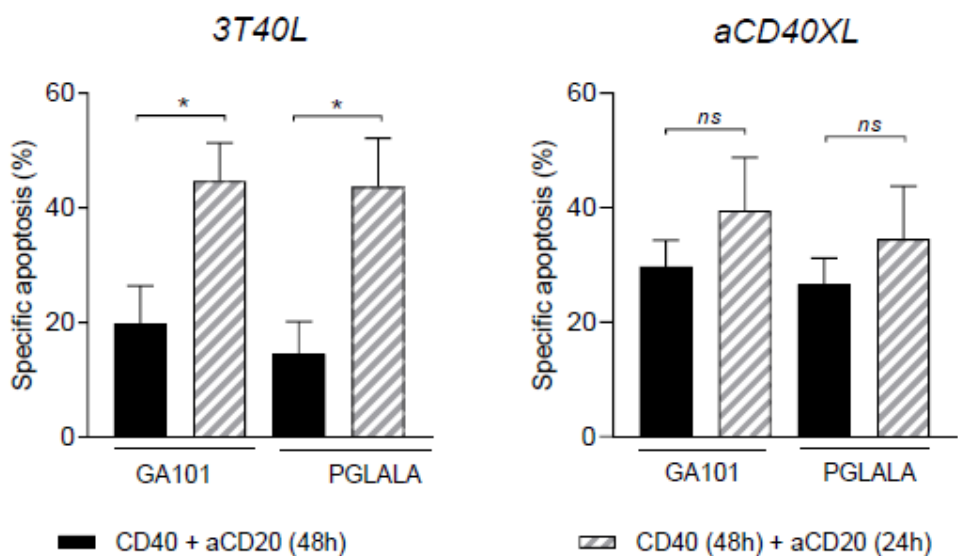
Figure 7. Order of events: selicrelumab demonstrated no significant difference between co-stimulation and anti-CD20 treatment. Comparison between CD40 stimulation simultaneously with anti-CD20 mAbs treatment for 48 h, and CD40 stimulation (48 h) before anti-CD20 mAb treatment (24 h), for co-culture system and aCD40XL ( n = 6). Bars represent the mean ± SEM: * p <0.05 (unpaired t-test).